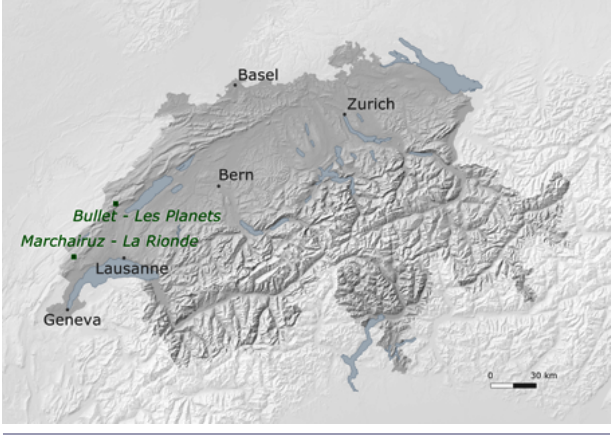
Fig. 2 . Map of Switzerland showing the location of the study regions in the Jura